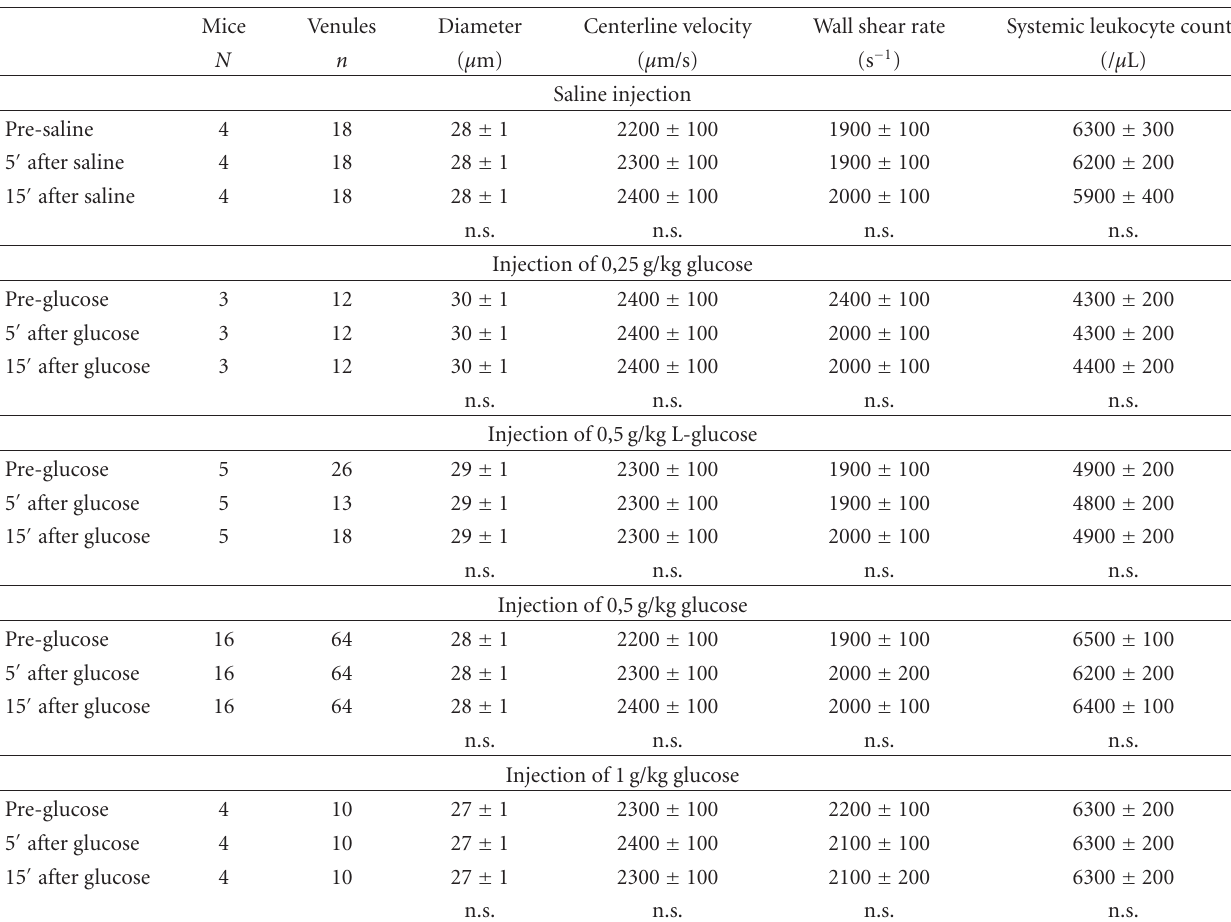
Table 1: Hemodynamic and microvascular parameters of cremaster muscle venules before and after stimulation with glucose in the trauma model. Vessel diameter, centerline velocity, and wall shear rate are displayed before and after the intravenous administration of di ff erent doses of glucose and compared to the application of the equivalent volume of normal saline and the biologically inactive L-glucose. Experiments are presented as mean ± SEM; n.s.: not significant, stating no di ff erences of hemodynamic parameters among the di ff erent doses and during the time course after glucose/saline injection.